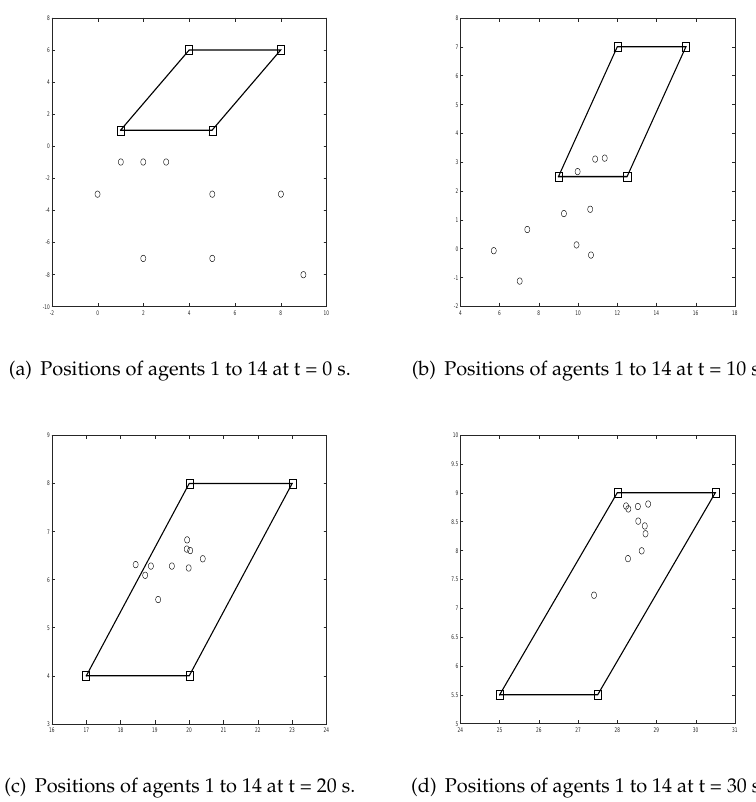
(c) Positions of agents 1 to 14 at t = 20 s. (d) Positions of agents 1 to 14 at t = 30 s. Figure 4. Positions of agents 1 to 14 using Algorithm 2 with τ = 0.1, where squares denote leaders and circles denote followers.